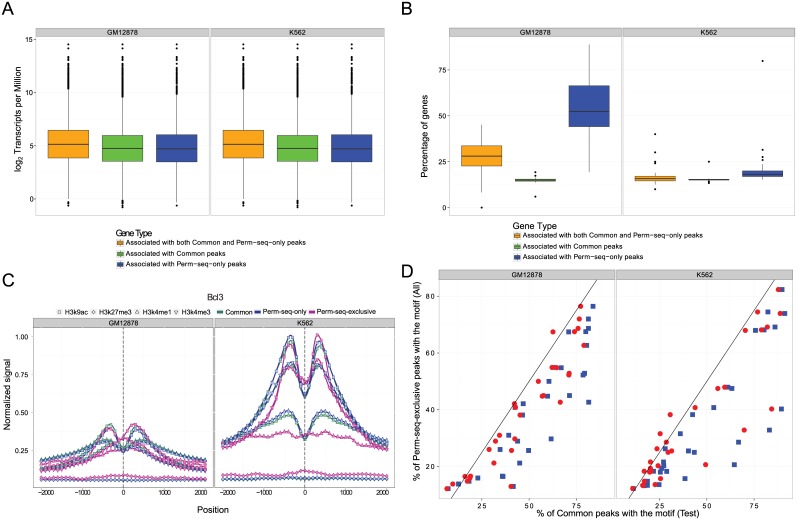
Comparison of uni-read and Perm-seq analysis.(a) Distribution of expression levels of genes with (i) Common peaks; (ii) Common and Perm-seq-only peaks; (iii) Perm-seq-only peaks. (b) Percentage of genes in segmental duplications with (i) Common peaks; (ii) Common and Perm-seq-only peaks; (iii) Perm-seq-only peaks. (c) Histone modification profiles within ± 2000 bps of the summits of the Common, Perm-seq-only, and Perm-seq-exclusive Bcl3 peaks in GM12878 and K562 cells, respectively. (d) Percentages of Perm-seq-exclusive and Common peak sets with the M1 motifs from the de novo sequence analysis of the top 500 Common peaks. Common peak set percentages are replaced by the percentages of occurrences in the subset of the Common peak sets (red circles) that is matched to Perm-seq-exclusive peaks in terms of ChIP signal.